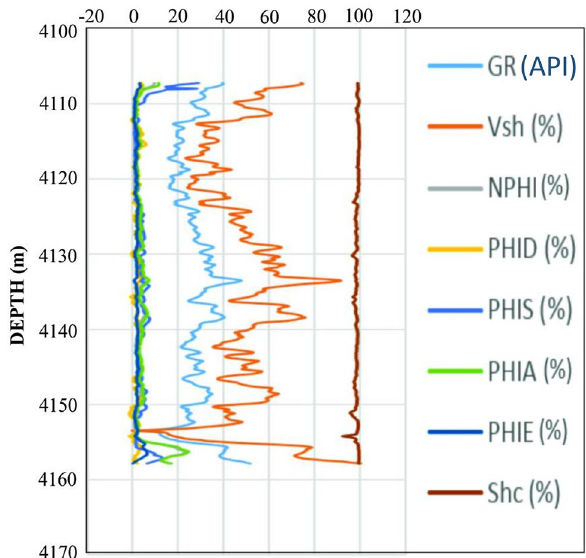
Fig. 7 Petrophysical logs of the Lockhart Limestone of Meyal-05P well